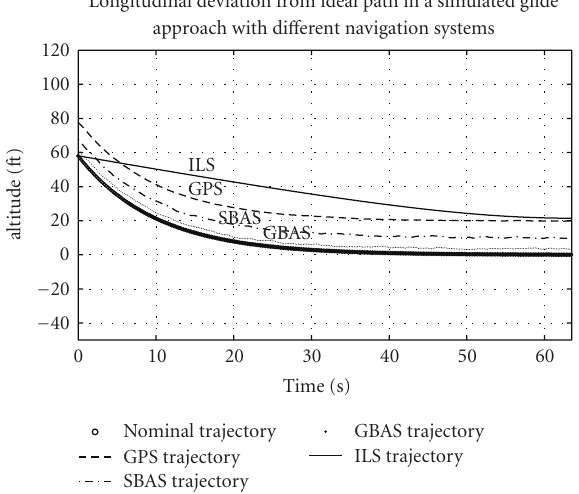
Figure 7: Longitudinal positioning comparison among di ff erent navigation systems.